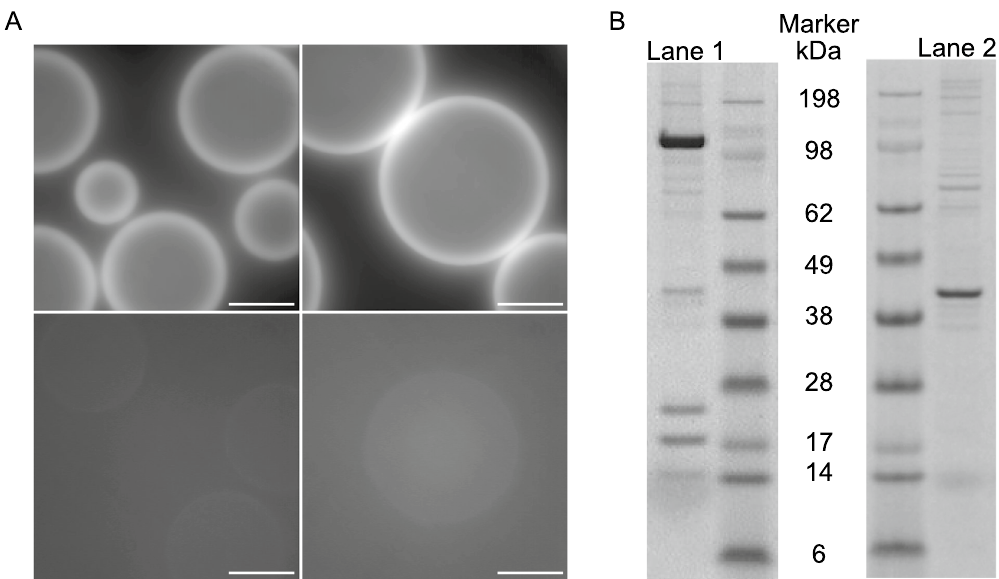
Figure 2. Affinity purification using anti-FLAG antibody resin (beads). ( A ) Top: GFP-fluorescence of beads after capturing the expressed proteins via FLAG tag. Bottom: Beads (shown under same microscopy conditions as on top) showing lost fluorescence after elution with 3X FLAG peptide. Scale bars: 200 µm. ( B ) Left: SDS- PAGE elution analysis showing purified human β-cardiac myosin heavy chain S1L-eGFP-FLAG construct (Lane 1, MHC; 125.5 kDa) co-purified with murine ELCs (~ 23 kDa) and RLCs (~ 19 kDa). Right: Mock purification using non-transfected C2C12 cells showing that small protein contaminants (Lane 2) are the results